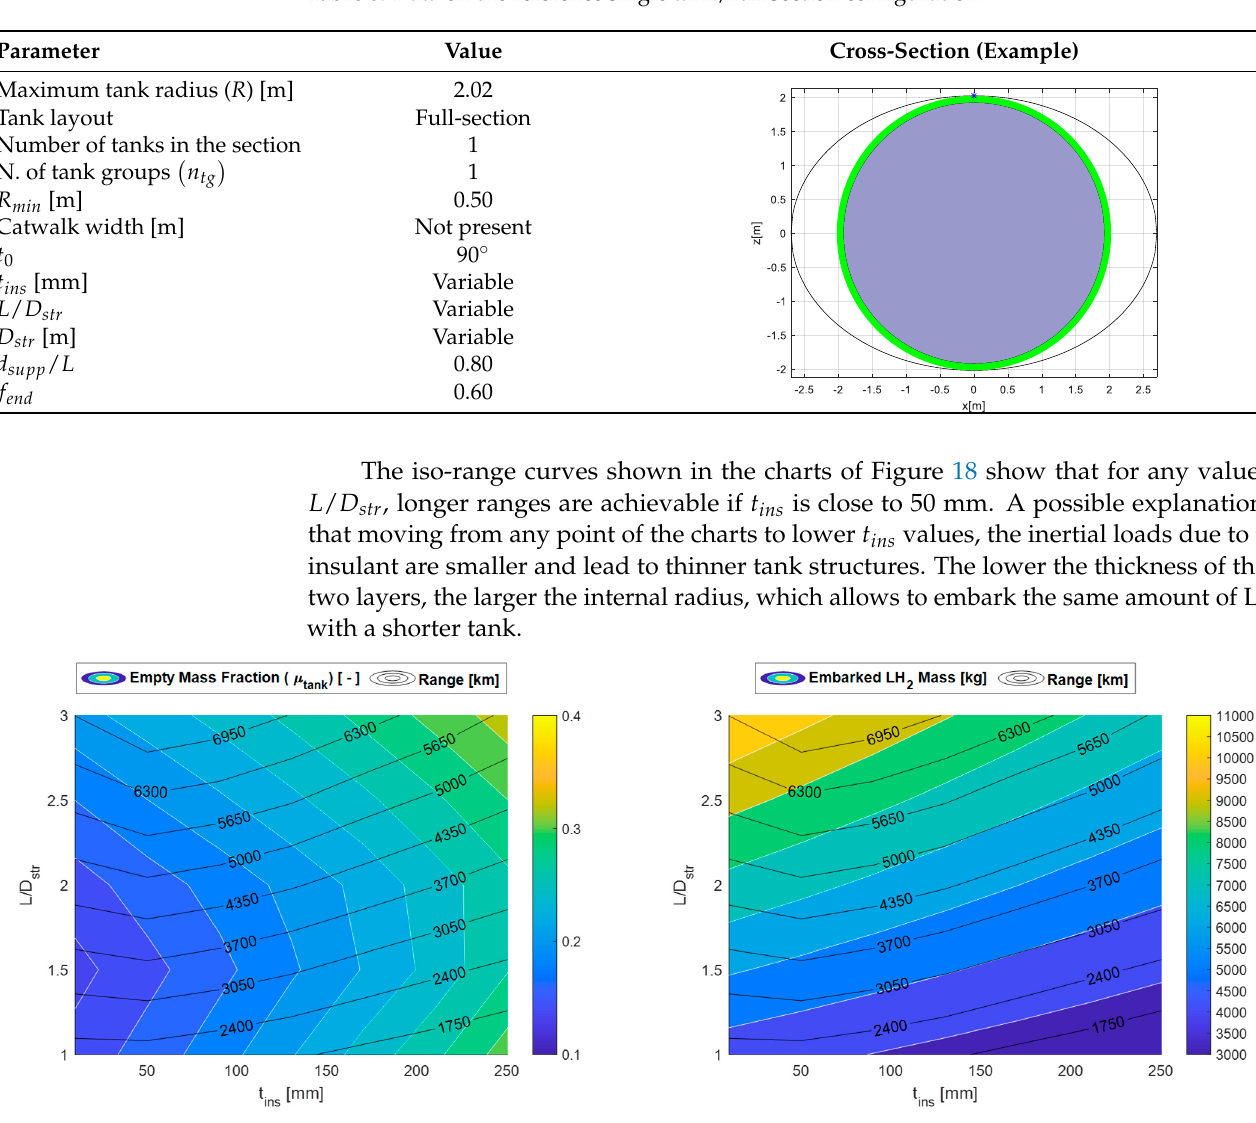
Table 8. Data on the reference single tank/full section configuration.